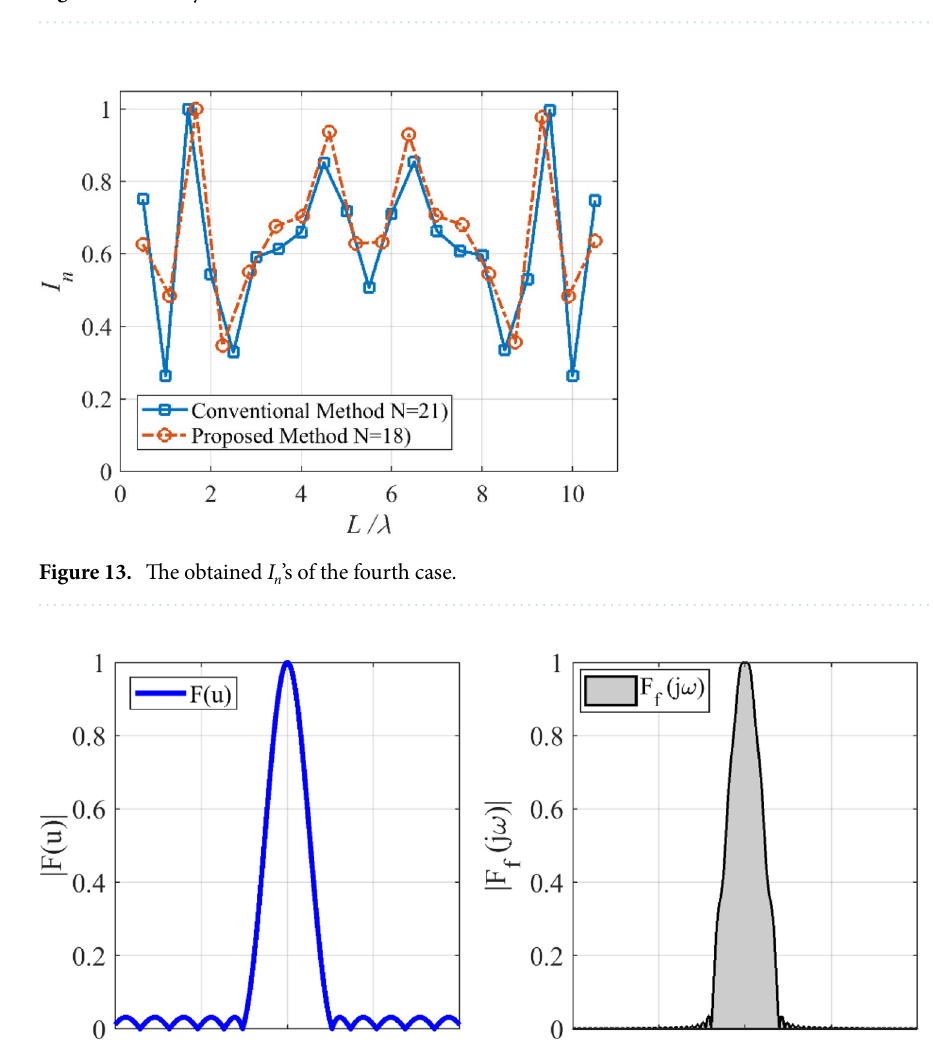
Figure 12. The synthesized results of the fourth case.